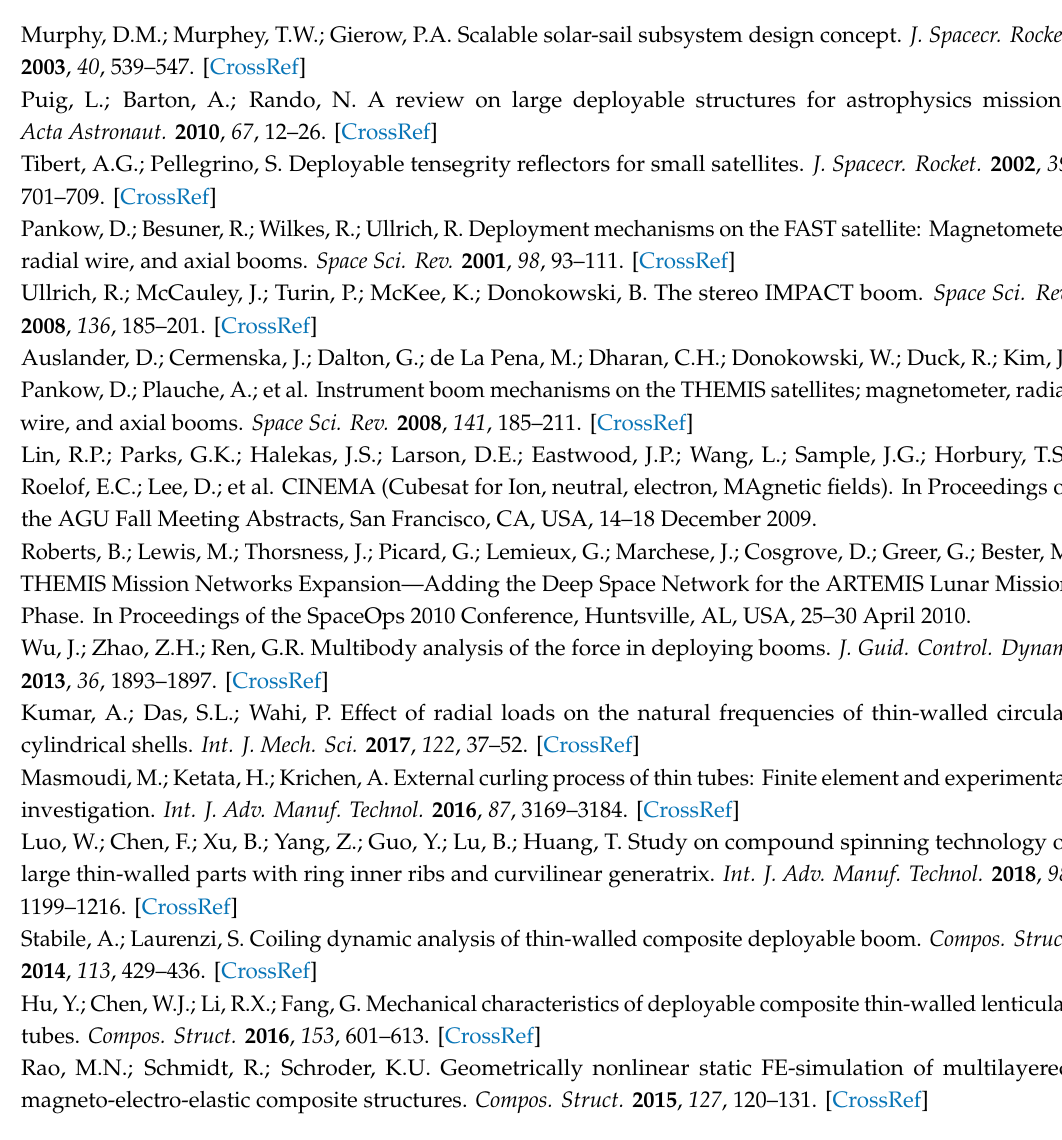
Figure S1: The spring reel with mesh sizes of ( a ) 0.99075 mm, ( b ) 2.06864 mm and ( c ) 3.03555 mm, Figure S2: The force on the top rod with di ff erent mesh sizes in the gathering